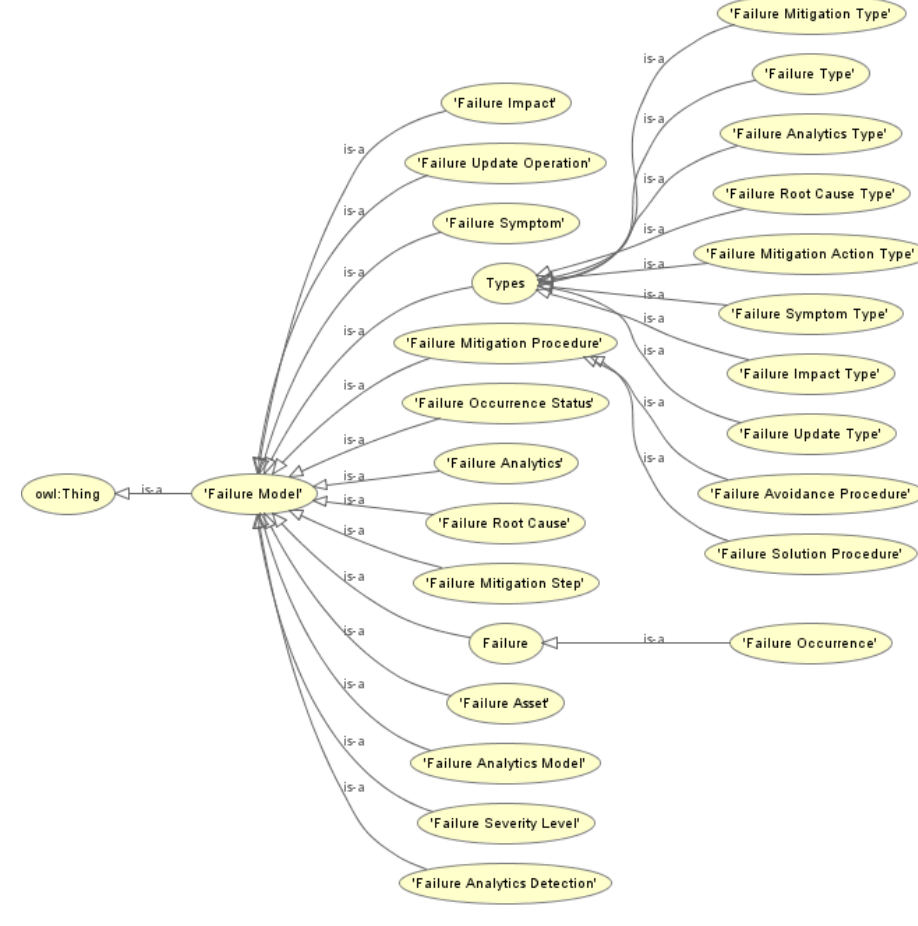
Figure 3. Failure